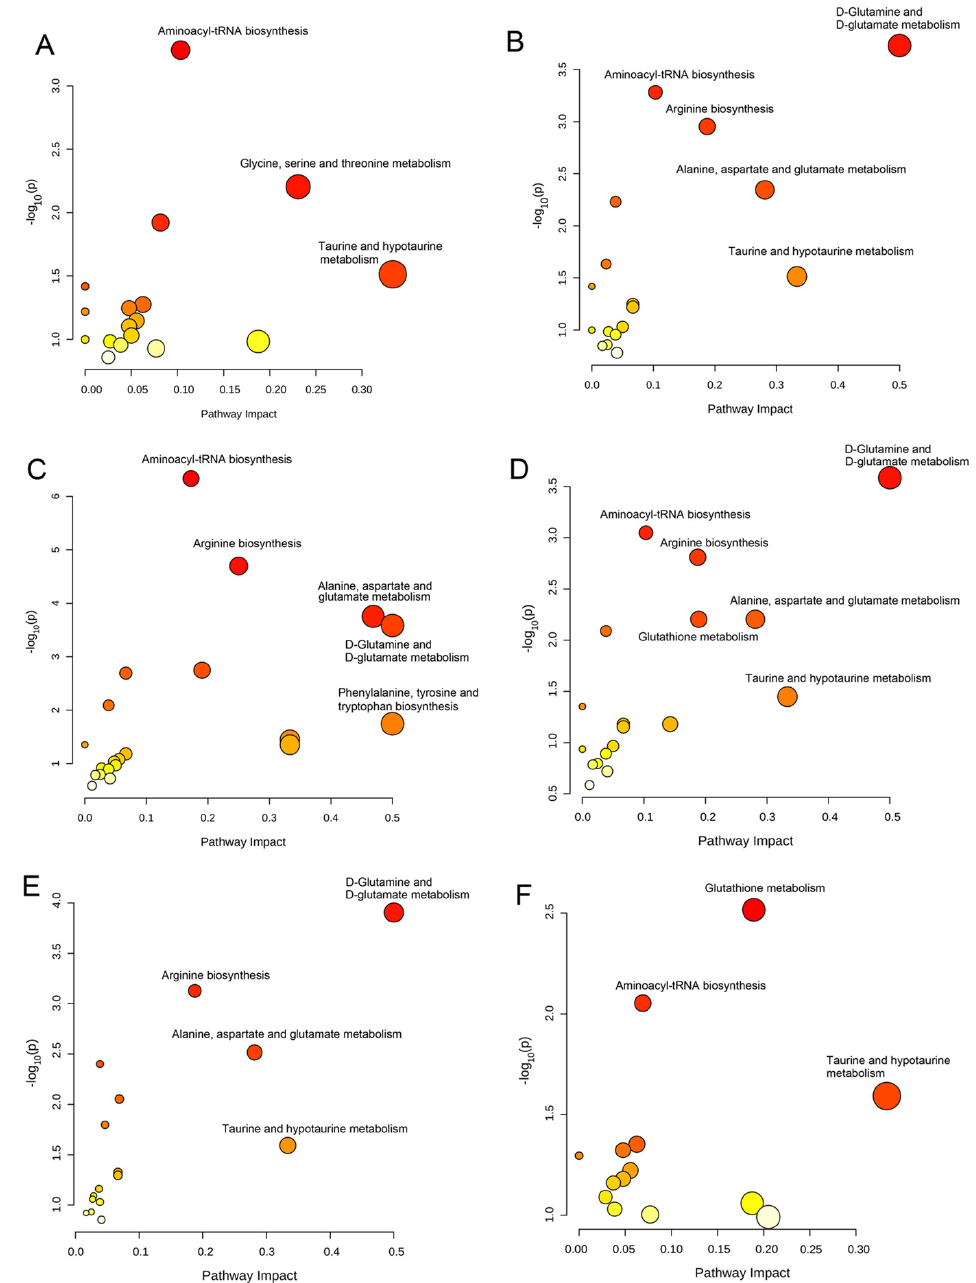
Figure 4. Significantly disturbed metabolic pathways were calculated in comparison between different coumarin derivative groups and the control group. ( A ) CD1 group vs. Control group; ( B ) CD2 group vs. Control group; ( C ) CD3 group vs. Control group; ( D ) CD4 group vs. Control group; ( E ) CD5 group vs. Control group; ( F ) CD6 group vs. Control group.